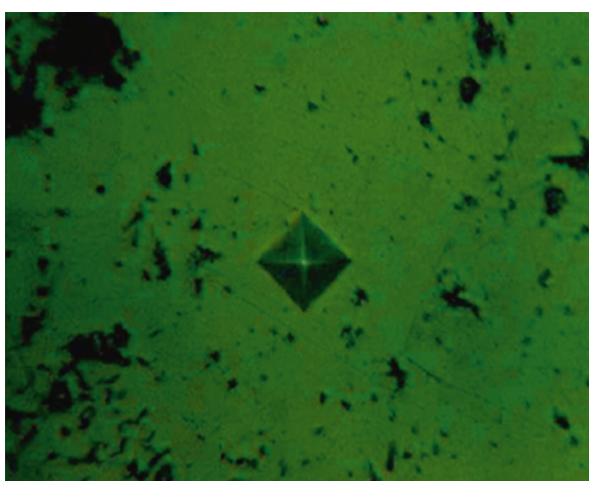
Figure 2: Microhardness indentation of